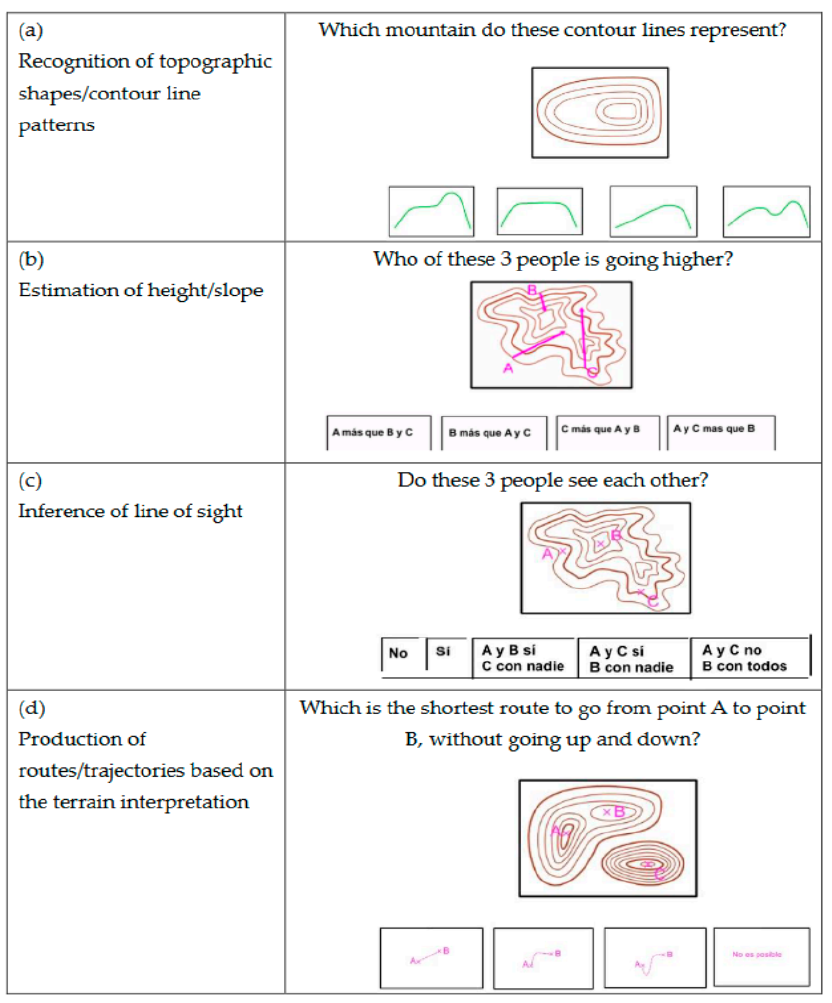
Figure 1. Selection of items from the final evaluation test